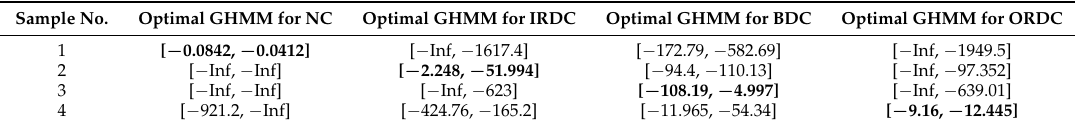
Table 4. Recognition results of fault types based on the GHMM; normal condition (NC), inner race defect condition (IRDC), ball defect condition (BDC) and outer race defect condition (ORDC). Sample No.